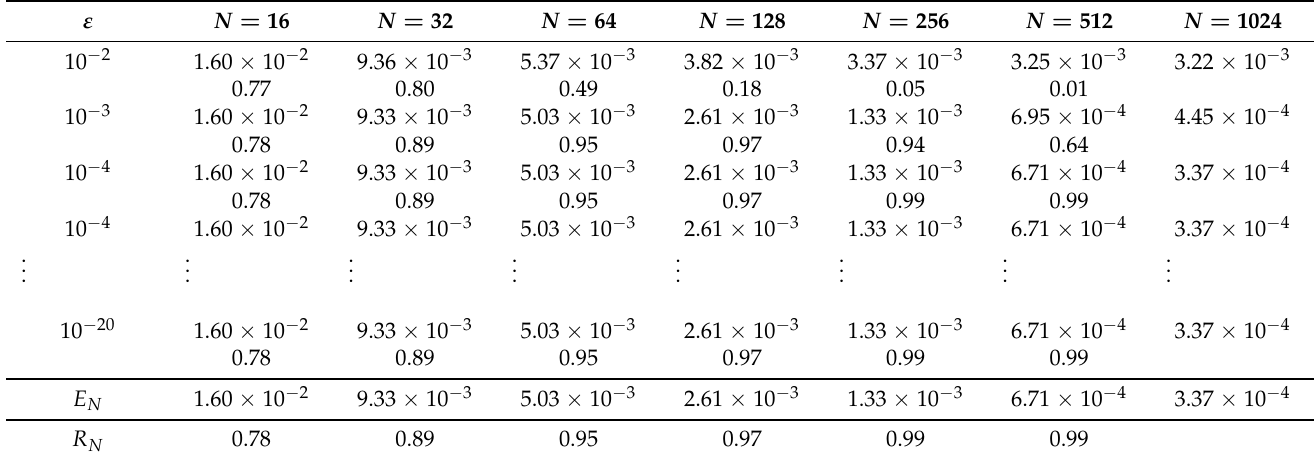
Table 1. Results for Example 1: maximum errors and convergence rates for FOFDM.